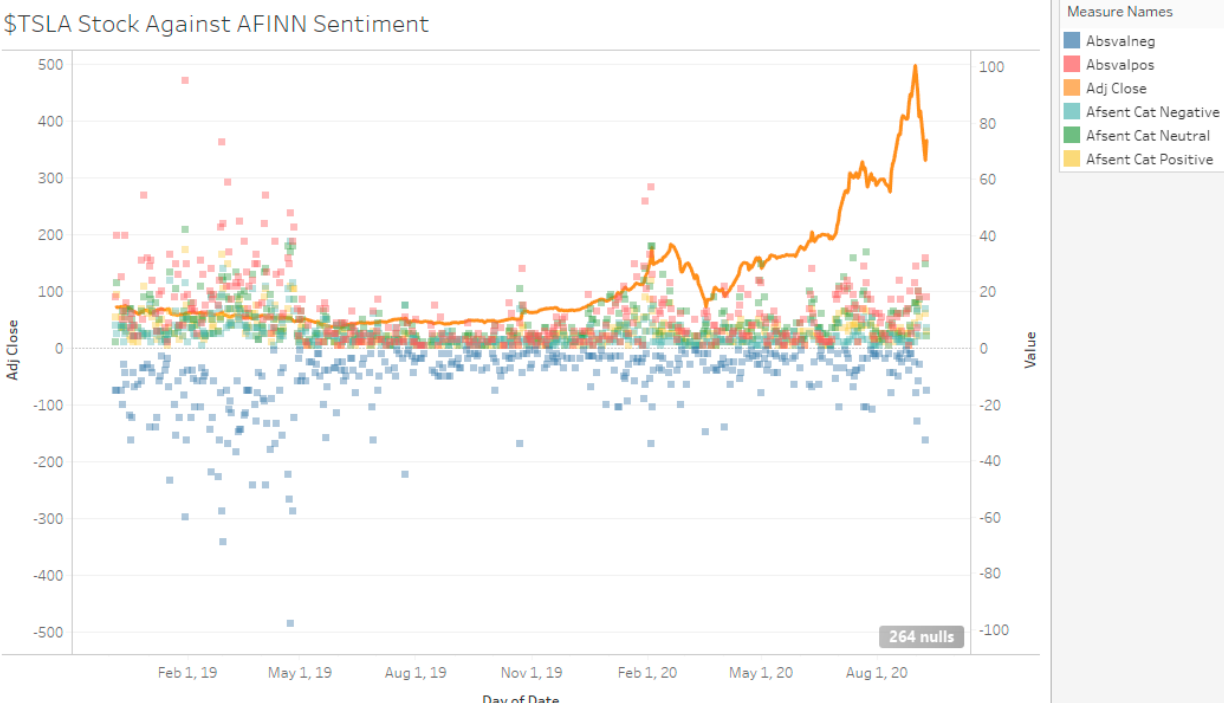
Sci 2023 , 5 , x FOR PEER REVIEW Figure 6. TSLA Stock Against AFINN Sentiment. Figure 6. TSLA Stock Against AFINN Sentiment.